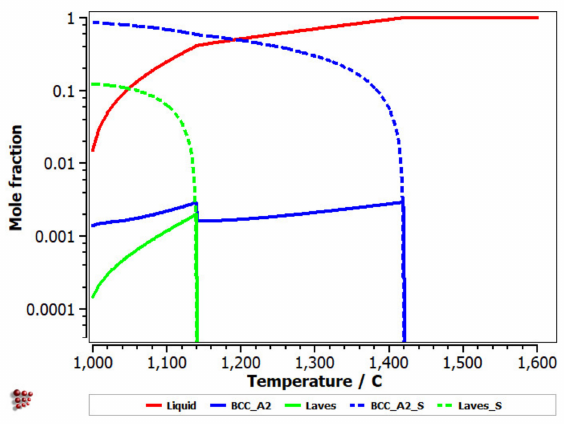
Figure 9. Scheill–Gulliver diagrams for FeMnNb 0.5 TiZr 0.5 .